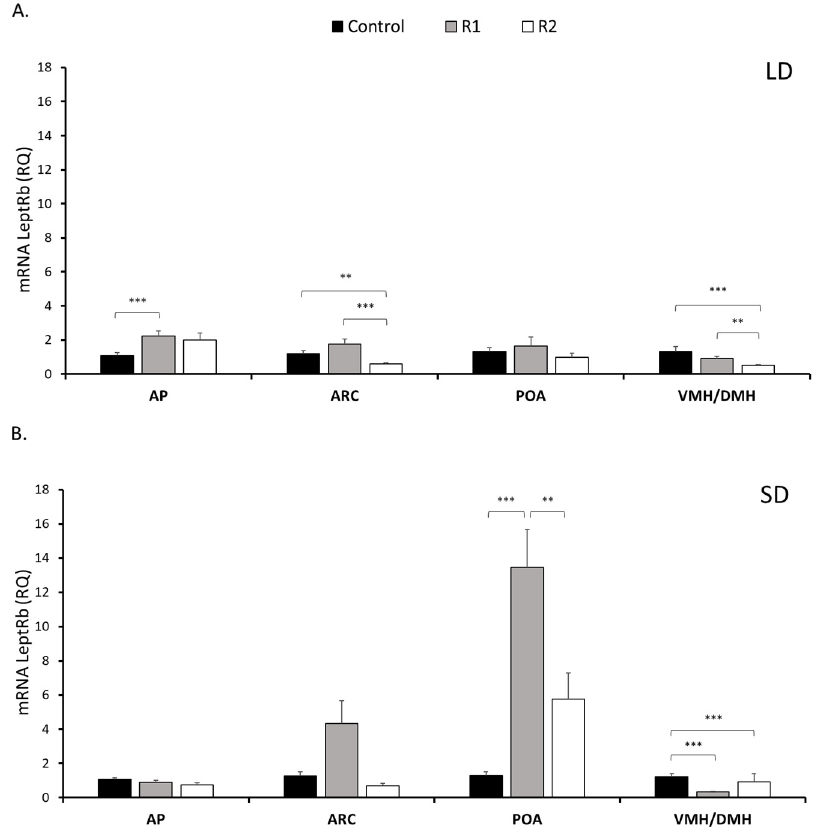
Figure 3. Leptin receptor expression. The mean mRNA expression (± SEM) of the long form of the leptin receptor (LeptRb) in the ovine anterior pituitary gland (AP), arcuate nucleus (ARC), preoptic area (POA) and ventro- and dorsomedial nuclei (VMH/DMH) collected during long-day (LD) (panel ( A )) and short-day (SD) (panel ( B )) photoperiods. The expression of LeptRb mRNA is reported in arbitrary units (RQ) relative to cyclophilin mRNA expression and expressed relative to the calibrator sample. Differences relative to the control or between the other groups are indicated with ** P < 0.01 or *** P < 0.001.